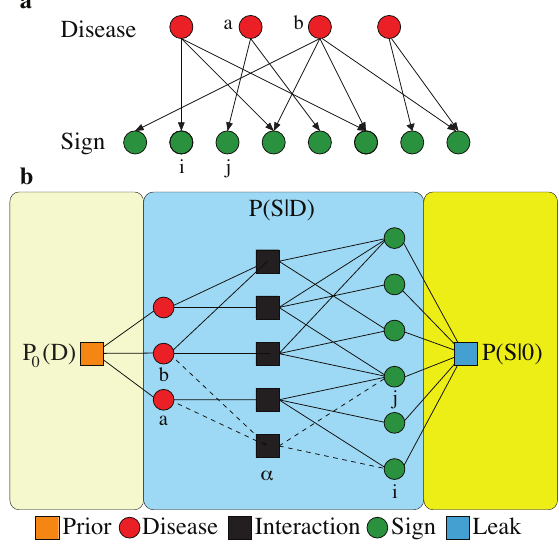
Figure 2. Probabilistic models of sign and disease variables: ( a ) A Bayesian belief network in the form of an acyclic directed graph showing the connections between the disease ( D a , D b ,... ) and sign ( S i , S j ,... ) variables. The model is completed by the conditional probability distribution P ( S interaction graph of disease variables (leftmost circles) and sign variables (rightmost circles) related by M a one-disease and M ab two-disease interaction factors (middle squares) in addition to interactions induced by the leak probability (right square) and the prior probability of disease (left square). (Adapted from reference